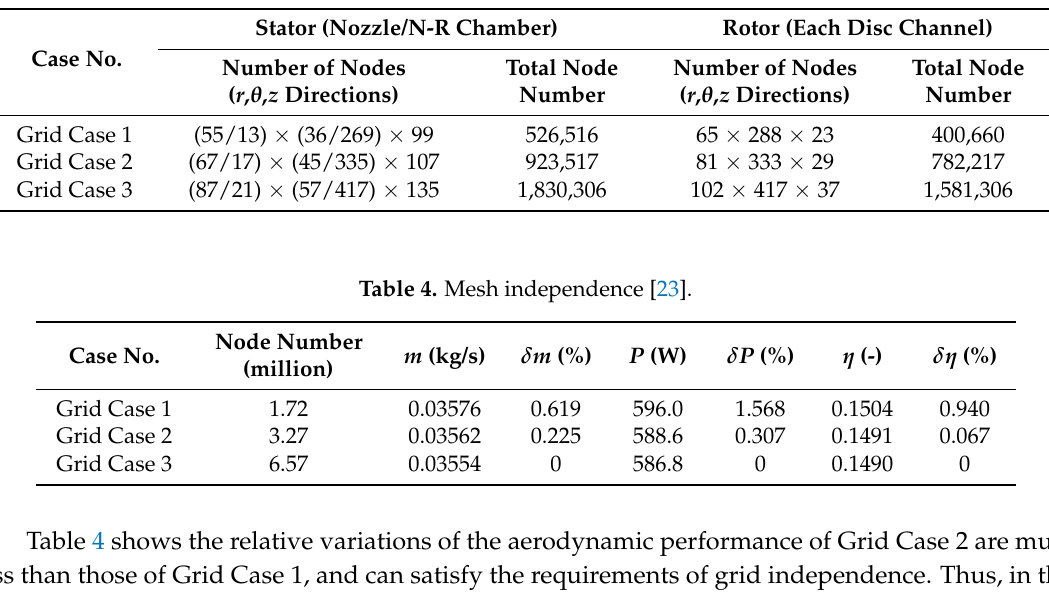
Table 3. Grid information [23].